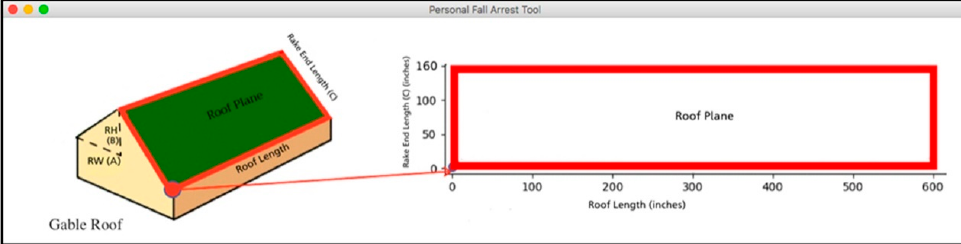
Figure 6. Roof geometry guide.